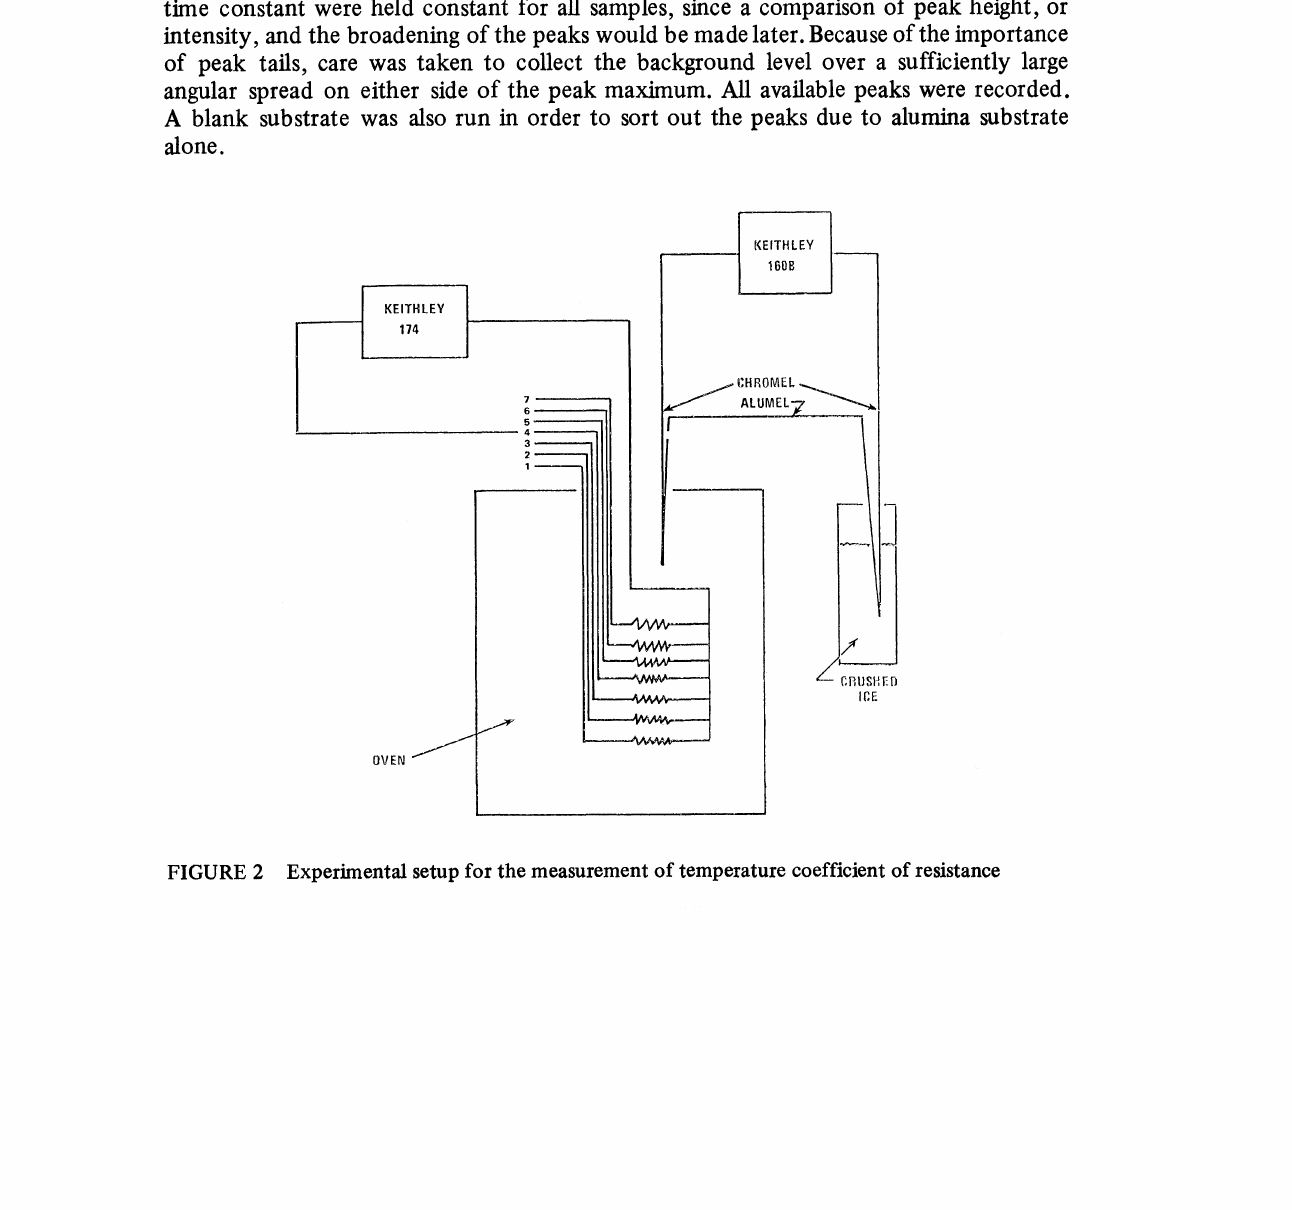
FIGURE 2 Experimental setup for the measurement of temperature coefficient of